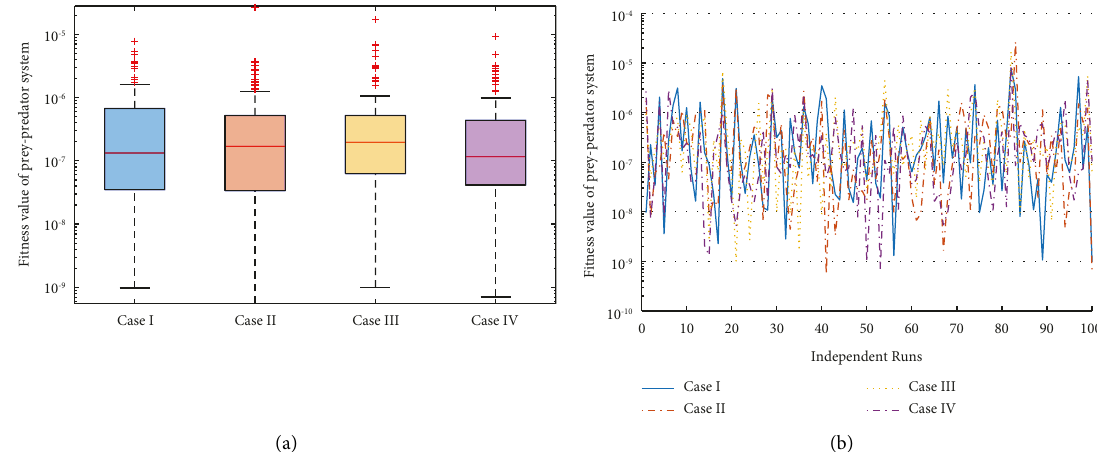
Figure 20: Comparison between the box plots and convergence graphs of fitness evaluation over 100 independent runs for the prey- predator model with variations in the catching rate of immigrant prey. (a) Box plots for fitness evaluation of the prey-predator model with variations in c . (b) Convergence of the fitness value of the prey-predator model with variations in c 2